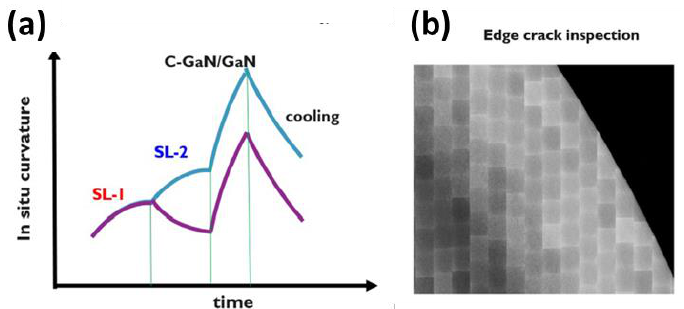
Figure 1. ( a ). Conceptual representation of stepped superlattice and reversed stepped superlattice. ( b ) CAMTEK edge inspection (the square pattern on the wafer is due to stitching of measurement shots) [81]. Figure reproduced with permission from AIP Publishing Applied Physics Letters.